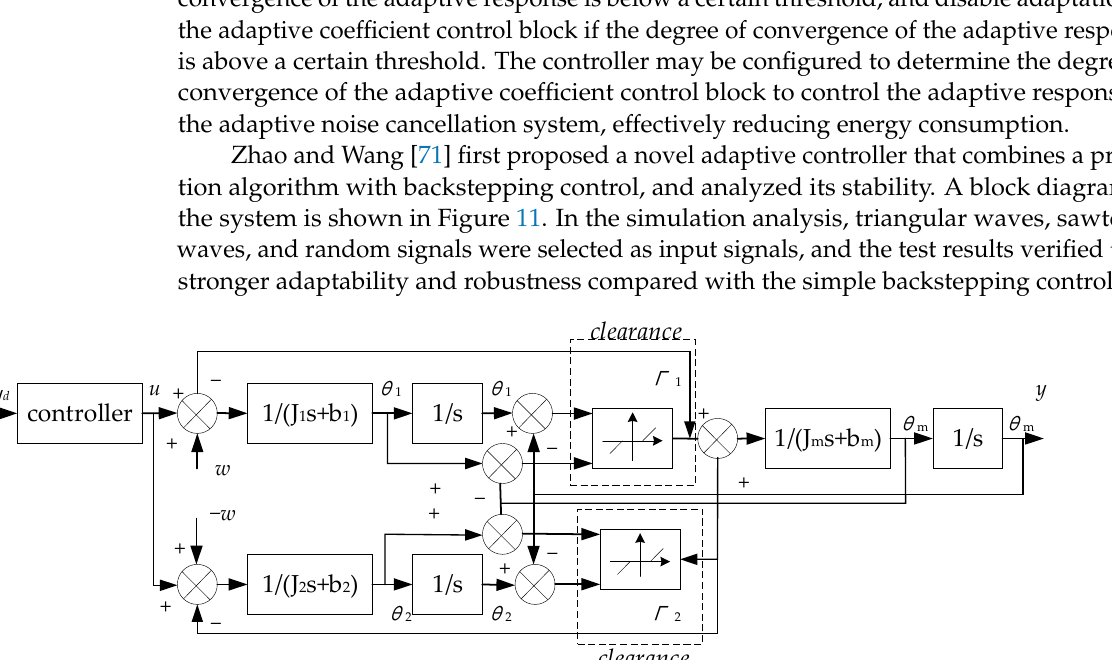
Figure 12. Structure of extreme learning machine-based super-twisting repetitive control (ELMSTRC) system.